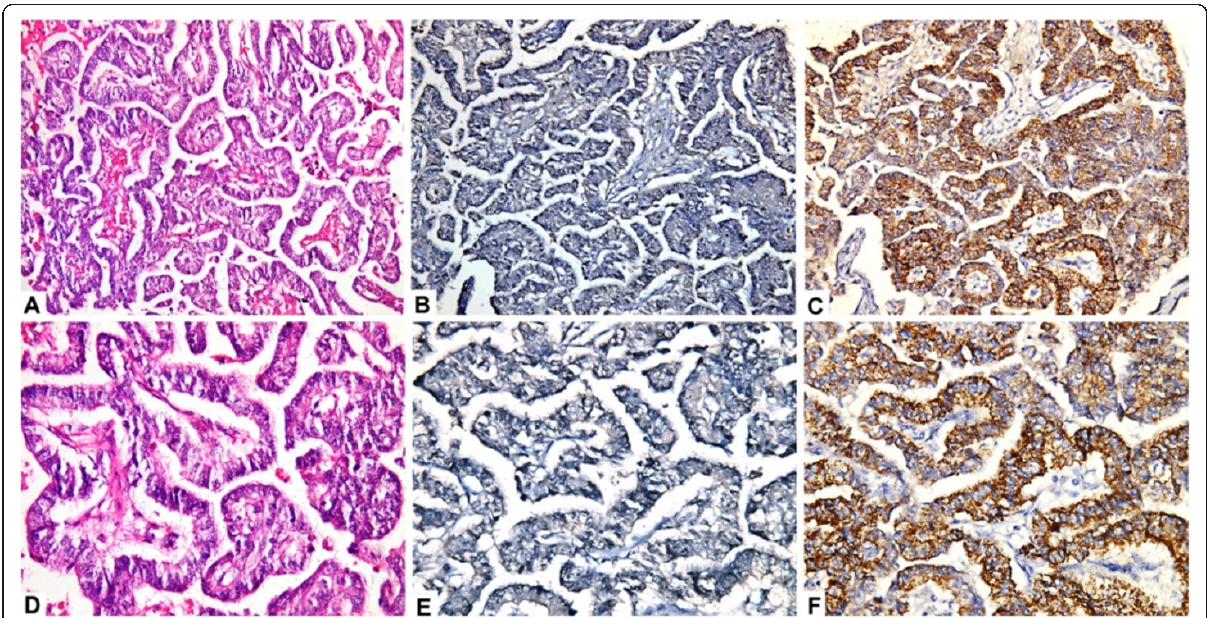
Figure 4 A case of metastatic colonic adenocarcinoma to the liver (A,D; H&E,original magnification x200,x400) showed negative arginase-1 immunostaining (B,E; immuoperoxidase, original magnification x200, x400), and stong and diffuse staining with HepPar-1 (C,F; immuoperoxidase, original magnification x200, x400).